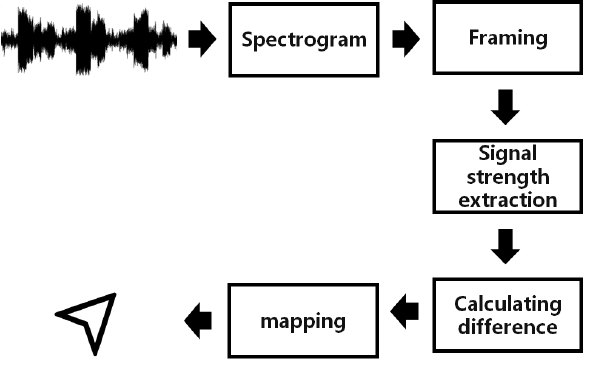
Figure 5. The signal processing flow of the user terminal.